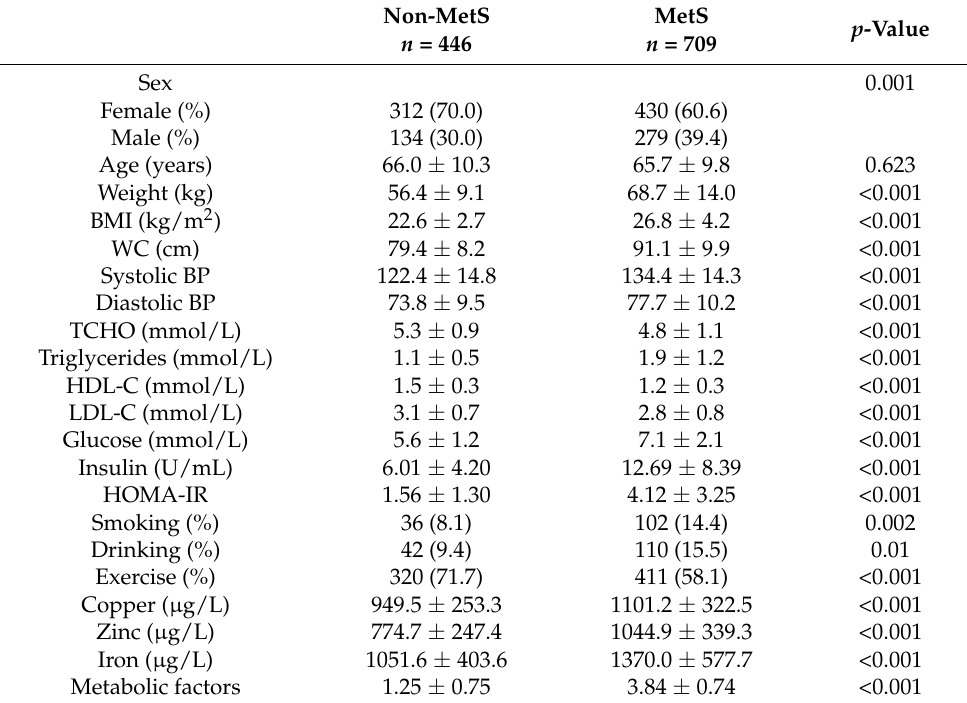
Table 1. Characteristics of the study population in non-MetS and MetS